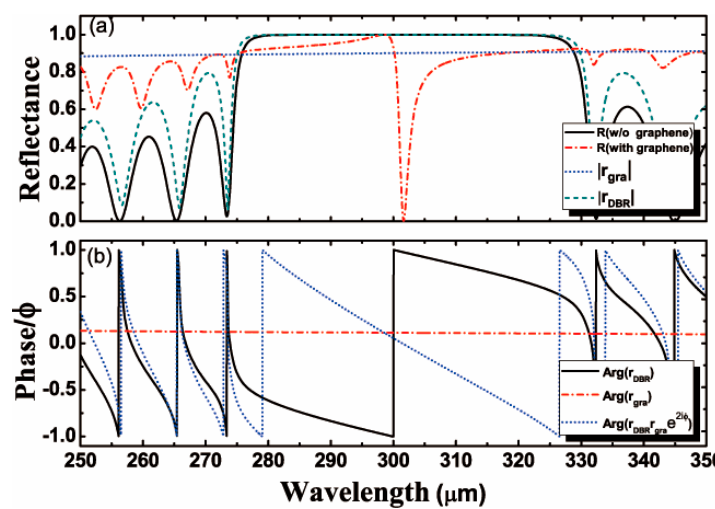
Figure 2. ( a ) The reflectance of the proposed structure (dash dot line), reflectance of the proposed structure in absence of graphene (solid line), reflectance r gra for graphene sensing medium interface (short dot line), and reflectance r DBR for the sensing medium 1D PC interface (short dashed line) as a function of wavelength; ( b ) the phase of r gra (dash dot line), r DBR (soild line), and r DBR r gra e ( 2 i φ ) (short dotted line) as a function of wavelength.